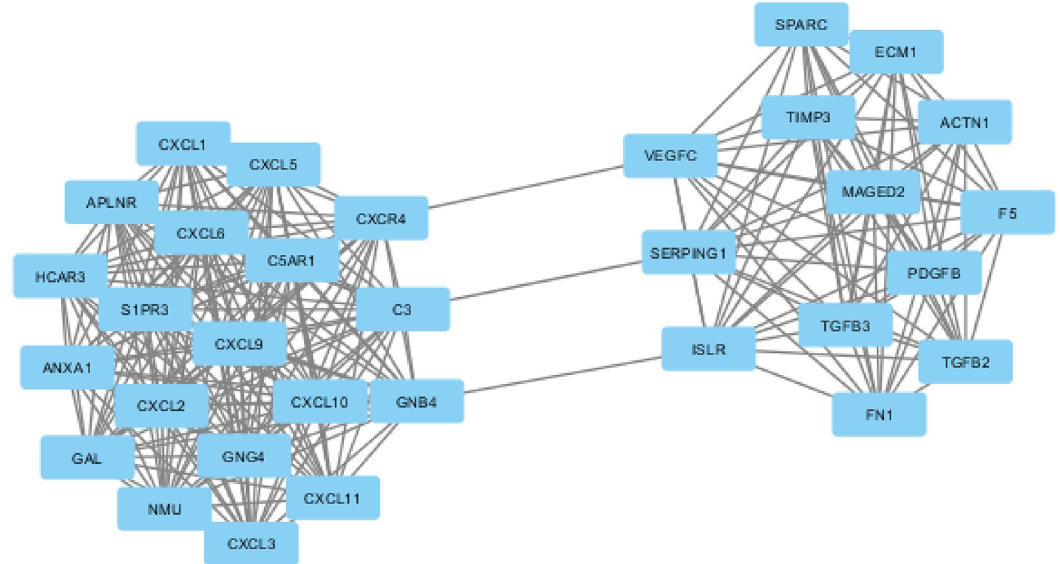
Fig 6. HCAR3 module contained two subgroups. The color and size of the nodes indicated the input p value and the frequency of the GO term generated from GOA database; edges that linked nodes in the graph indicated